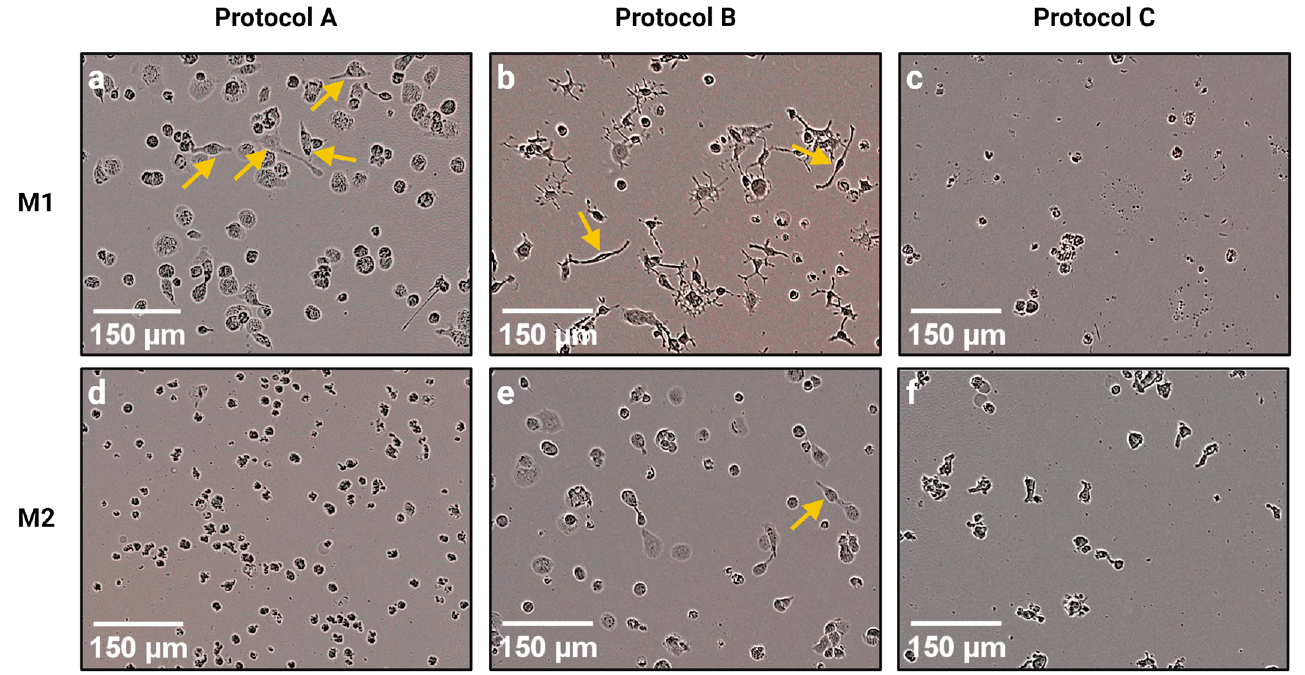
Figure 2. Visualization of polarized macrophages. Images were obtained immediately after removing the polarization stimuli for each M φ subset (for time points see Figure 1) by the IncuCyte ® ZOOM reader with 10× objective using the brightfield channel. Yellow arrows point to cells with spindle-like morphology. ( a ) M1_A; ( b ) M1_B; ( c ) M1_C; ( d ) M2_A; ( e ) M2_B; ( f ) M2_C. Created with BioRender.com; accessed on 12 th December 2022.